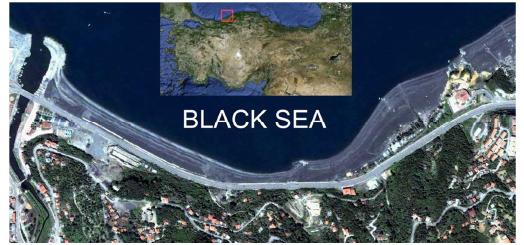
Figure 1 Zonguldak Coastal Test Field